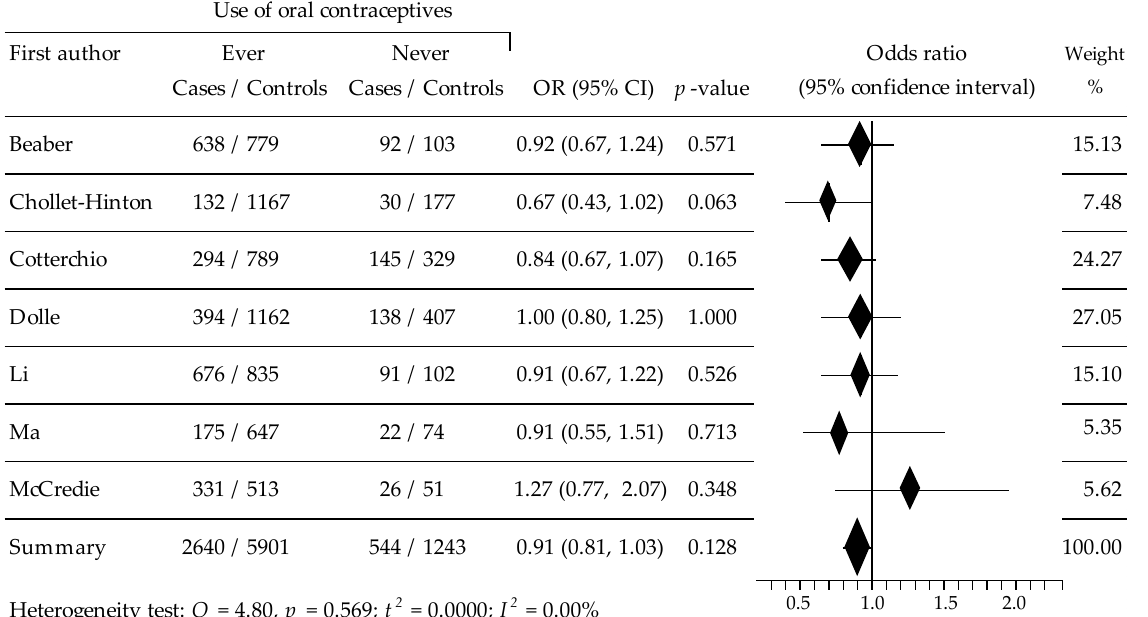
significant risk reduction: OR = 0.89, 95% CI: 0.64 to 1.24, p = 0.493, I 2 = 52.91%. Multivariable meta-regression with covariates of the age of first use of OCs ( β = 0.03, 95% CI: − 0.32 to 0.38, p = 0.860), duration of use of OCs ( β = 0.06, 95% CI: − 0.16 to 0.27, p = 0.602), and time since last use ( β = 0.25, 95% CI: − 0.14 to 0.64, p = 0.212) showed these covariates had a non-significant impact on breast cancer risk in premenopausal women.